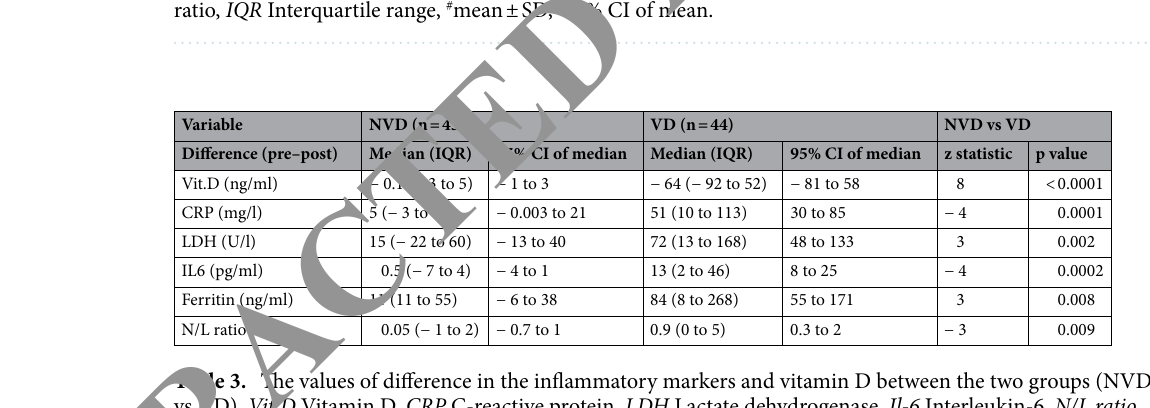
Table 3. The values of difference in the inflammatory markers and vitamin D between the two groups (NVD vs VD). Vit.D Vitamin D, CRP C-reactive protein, LDH Lactate dehydrogenase, Il-6 Interleukin-6, N/L ratio